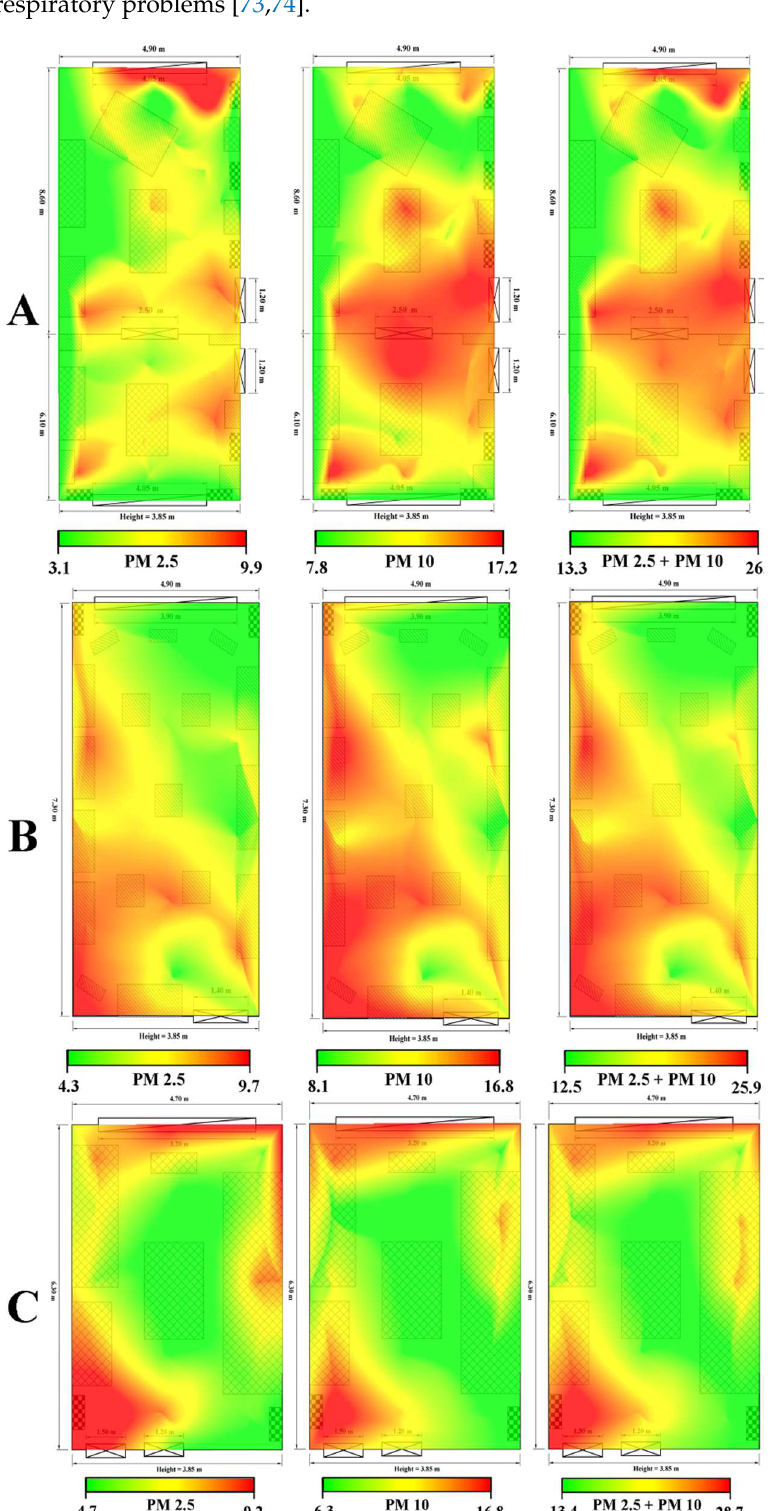
Figure 7. Spatial distribution of suspended particles (PM 2.5 , PM 10 and their combination) within the three analyzed rooms of Darvas-La Roche House, determined in µ g/m 3 (( A )—The great hall–1st floor; ( B )—Exhibition hall–Ground floor; ( C )—Bedroom–1st